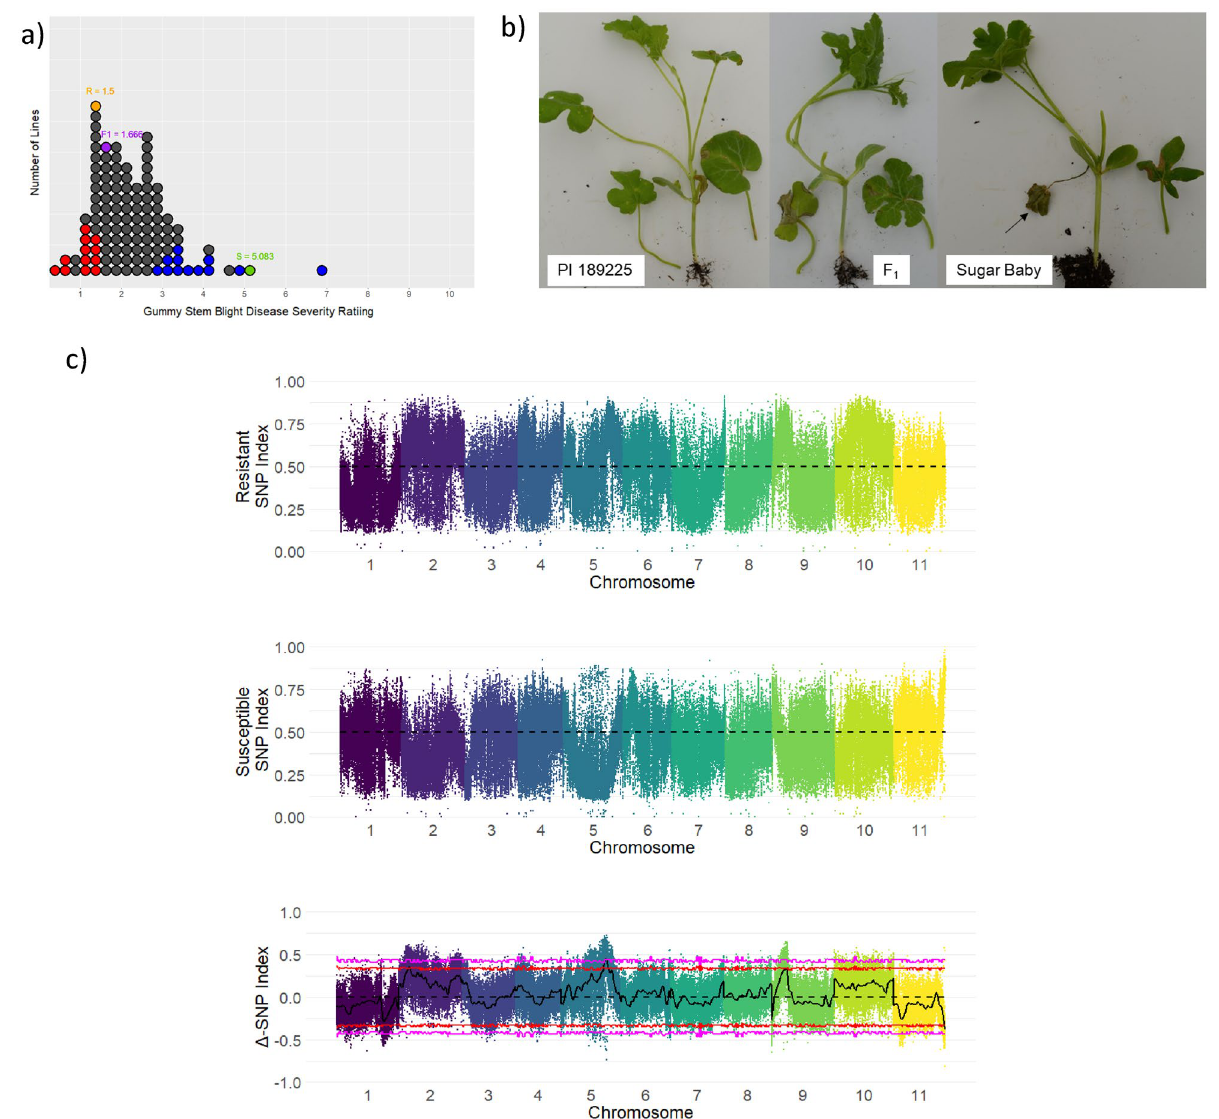
Figure 1. ( a ) Stacked dot plots showing the distribution of the average disease severity of the F 2:3 families (n = 111) of a cross between Sugar Baby (S) and PI 189225 (R). Red and blue dots represent the families selected to generate the resistant and susceptible DNA bulks, respectively. The orange, purple, and green dots represent the average phenotypic values for PI 189225, the F 1 , and Sugar Baby, respectively. ( b ) Gummy stem blight disease severity in PI 189225 (resistant), the F 1, and Sugar Baby (susceptible) after infection with S. citrulli . The black arrow indicates a completely dead leaf in the susceptible parent. ( c ) The SNP index for the gummy stem blight resistant and susceptible bulks and the Δ-SNP index of each identified SNP. Individual colored points represent individual SNPs, with each color representing a different chromosome. The black line represents the tricube smoothed Δ-SNP index value using a 1 Mb sliding window. The red line represents the 95% confidence interval and the pink line represent the 99% confidence interval. A positive Δ-SNP index represents SNPs differing from the reference genome which are potentially contributing to the trait of interest, while regions with a negative Δ-SNP index represent SNPs shared with the reference genome which are potentially contributing to the trait of interest. Regions where the black line exits the bounds of the confidence intervals represent potential QTL for gummy stem blight resistance. Δ-SNP indices were calculated using QTLseqr 48